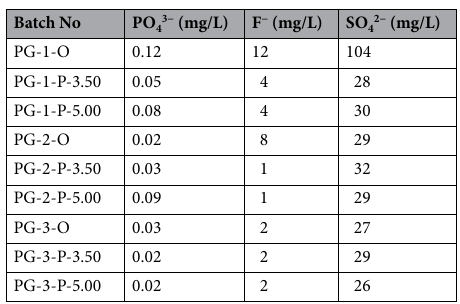
Table 4. Experimental data of the backfill